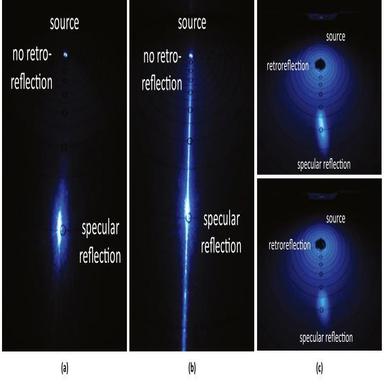
Simple goniometer images of violet (405 nm) laser light at 70° incidence reflected from two non-retroreflective surfaces (a, b) and one retroreflective surface (c). Panel a shows a mirror calibration standard exhibiting purely specular reflection; panel b shows a polished aluminum panel exhibiting specular reflection; and panel c shows a Type 1 white retroreflective safety film, exhibiting both specular reflection and retroreflection. Upper and lower images in panel c show the maximum and minimum specular